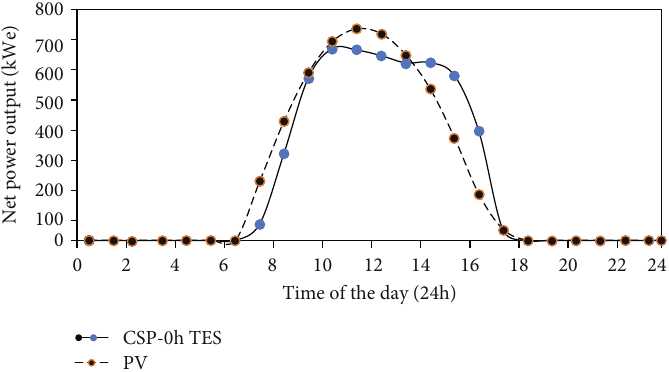
Figure 16: Typical annual net power output pro fi le of PV and PT-CSP systems without TES.